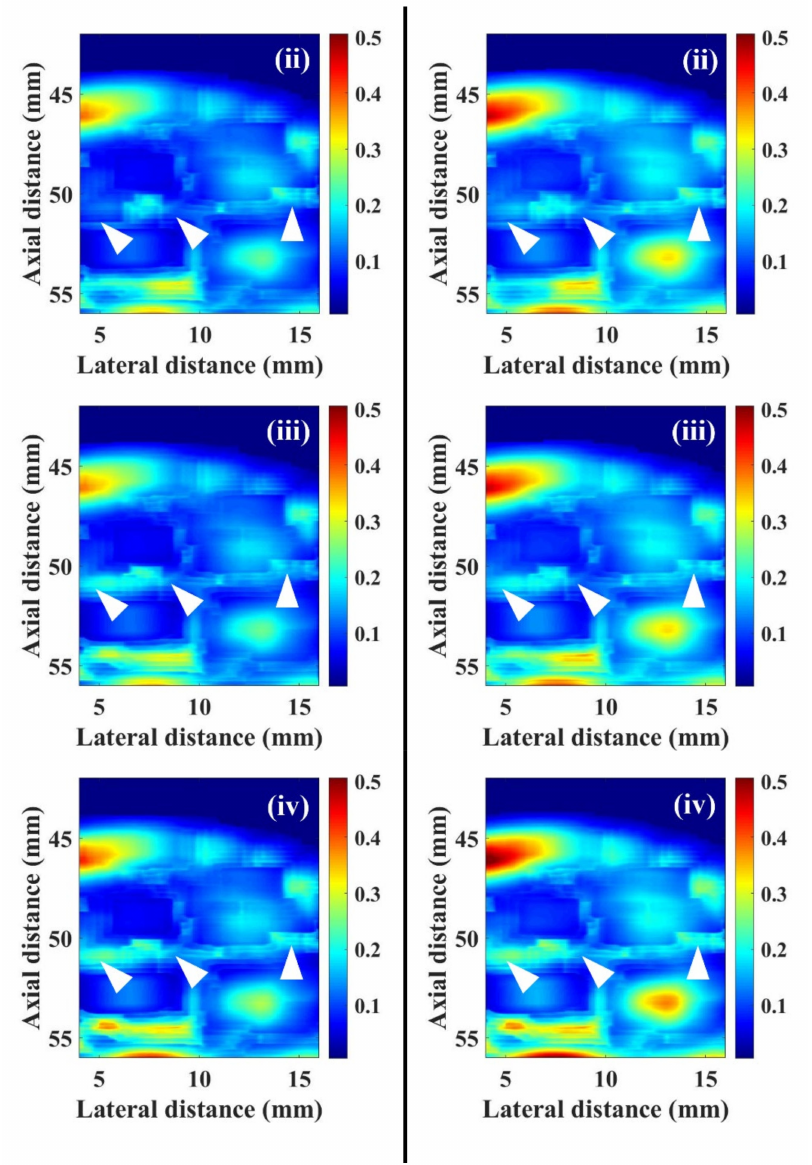
Figure 10. WMC Nakagami images of muscle tissue at (i) pre-contrast, (ii) 55 s, (iii) 75 s, and (iv) 110 s, following UCAs administration corresponding to the incidence of ( a ) 2.86 and ( b ) 4.37 MPa acoustic pressures. The perfusion areas of UCAs are indicated by white